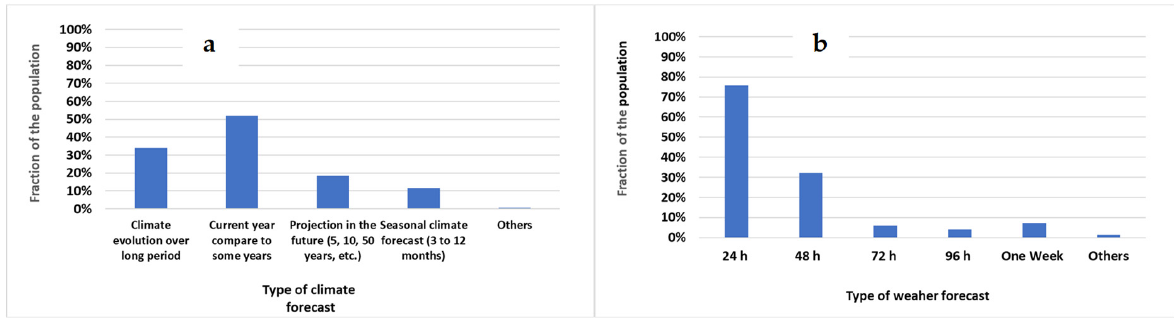
Figure 3. Types of climate ( a ) and weather ( b ) information received by producers in the communities surveyed in Western Niger.